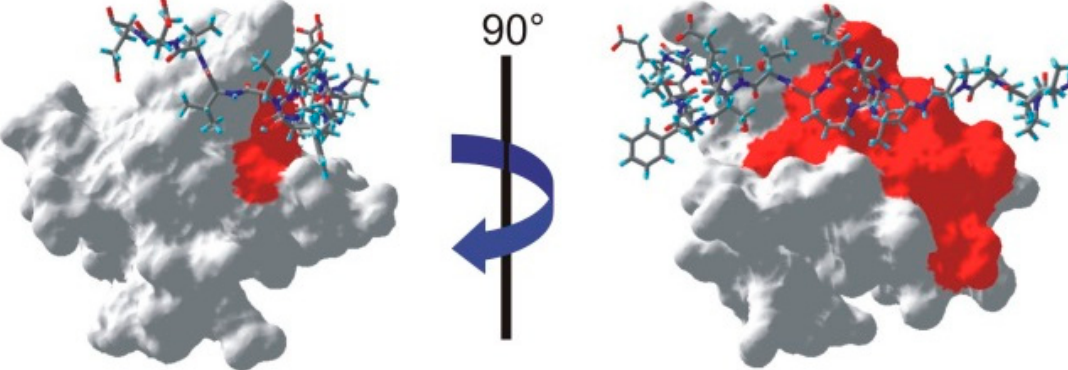
Figure 6. Mapping of the interface on one NMR structure of the SH3-PEP complex (PDB: 1JEG [19]). The peptide appears as a stick-plot lying on the surface of the SH3 domain. Every residue for which one proton is below the threshold shown in Figure 3 appears in red on the surface of the SH3 domain.